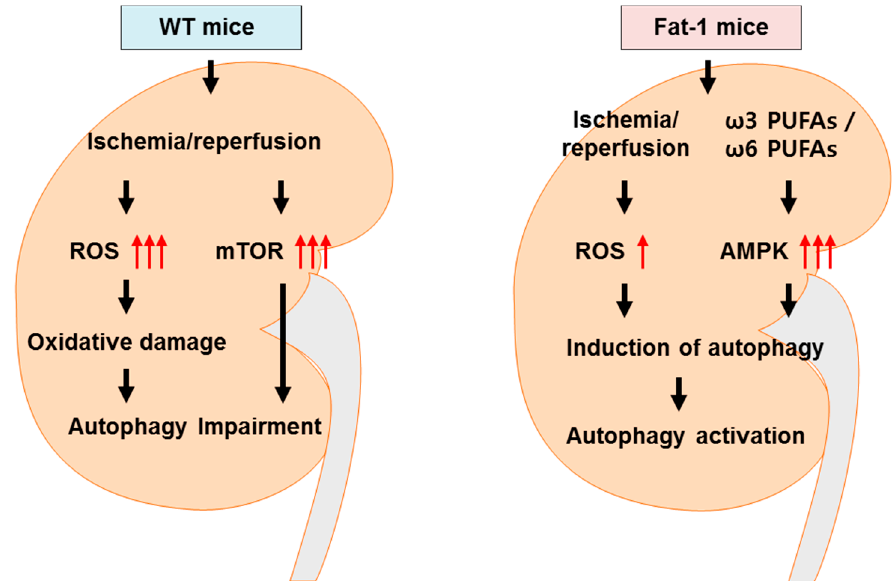
Figure 6. Schematic diagram. Ischemia-reperfusion (IR) increases kidney damage, with increased oxidative stress and less pronounced AMPK activation. Activation of AMPK inhibits reactive oxygen species-induced autophagy impairment and induces autophagy, resulting in preserved adenosnine triphosphate (ATP) content and kidney homeostasis. AMPK-mediated autophagy was reduced in wt mice damaged by IR, prompting kidney dysfunction. However, in fat-1 mice, high ω 3-PUFAs increased AMPK-mediated autophagy and protected the kidney against IR via induction of autophagy and enhancement of autophagy activation.